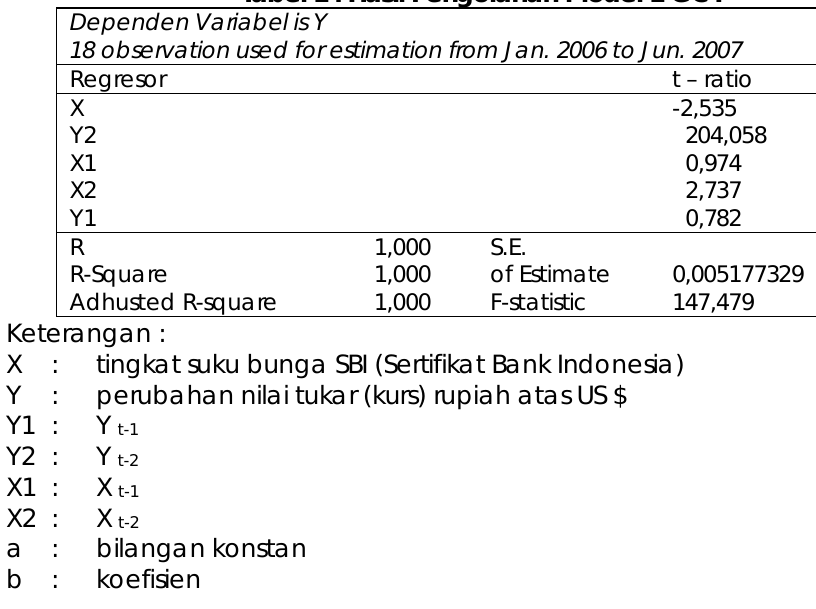
Tabel 1 : Hasil Pengolahan Model 1